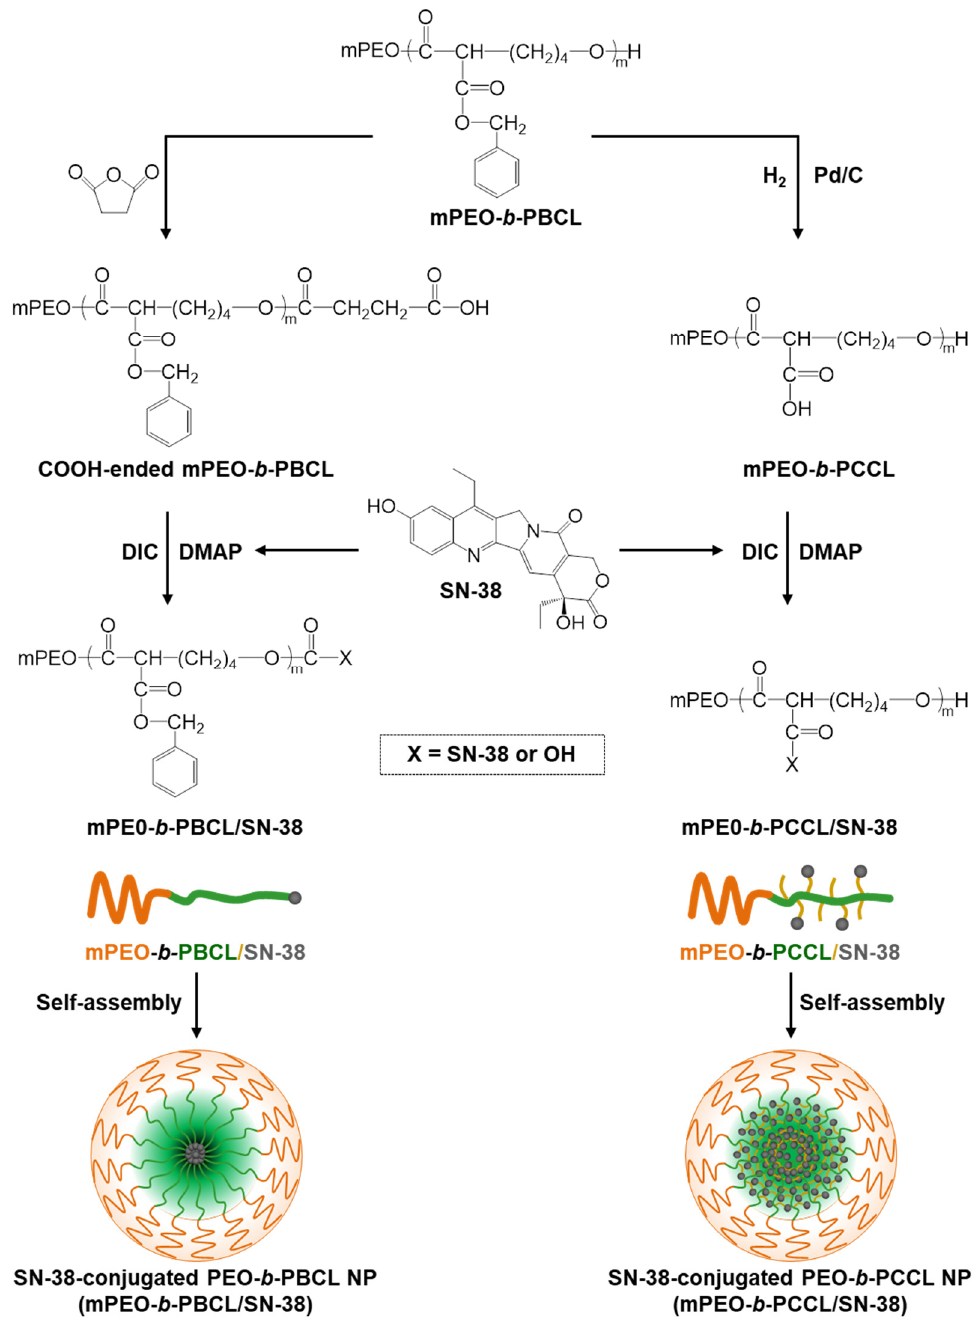
Figure 1. Chemical structures of SN-38, mPEO- b -PBCL, mPEO- b -PCCL, and schematic procedures to synthesize mPEO- b -PBCL/SN-38 and mPEO- b -PCCL/SN-38, forming self-assembled